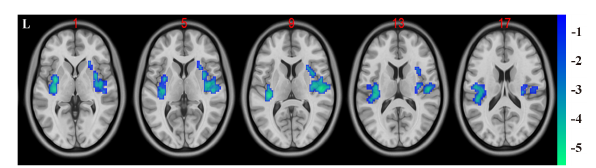
FIGURE 3 | Negative functional connectivity between the bilateral thalamus (defined as seed) and bilateral superior temporal gyrus and insula. A P -value lower than 0.001 ( P < 0.001) combined with cluster size larger than 110 voxels was considered as statistically significant (cluster-level false discovery rate corrected). Color bar indicated t -value between hemodialysis and healthy control groups.